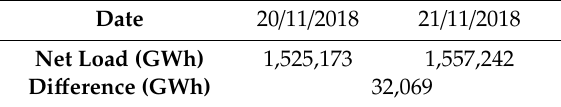
Figure 1. Net load curves for 20/11/2018 and 21/11/2018. Table 1. Net load difference between 20/11/2018 and 21/11/2018.